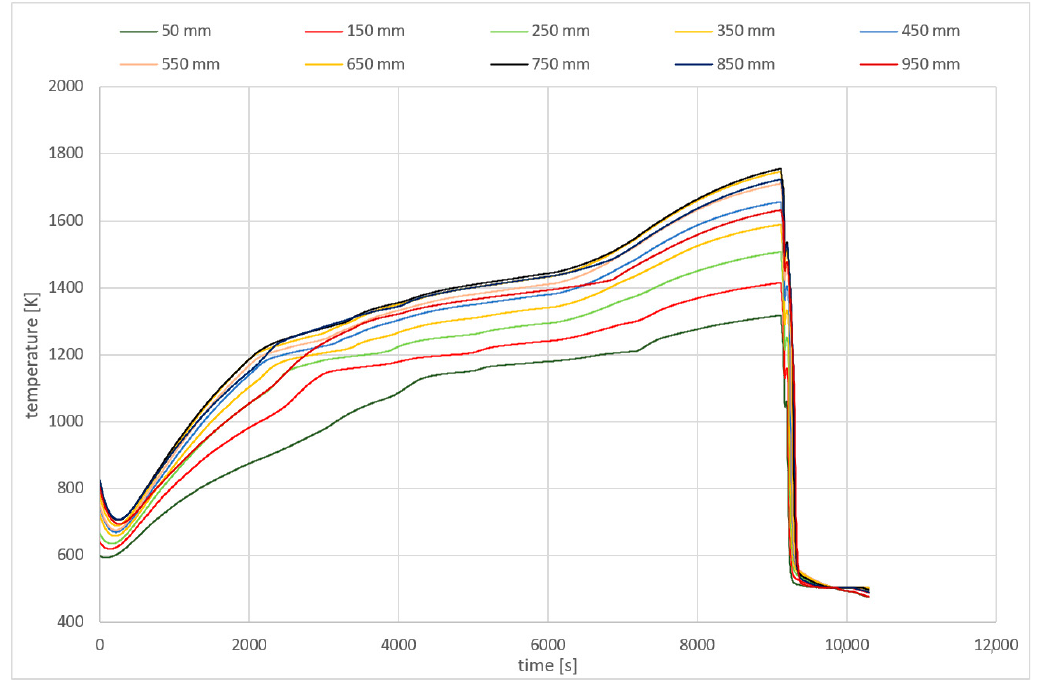
Figure 7. Temperatures calculated by MELCOR in the heated part of the bundle and the central ring (axial level, number of rings).